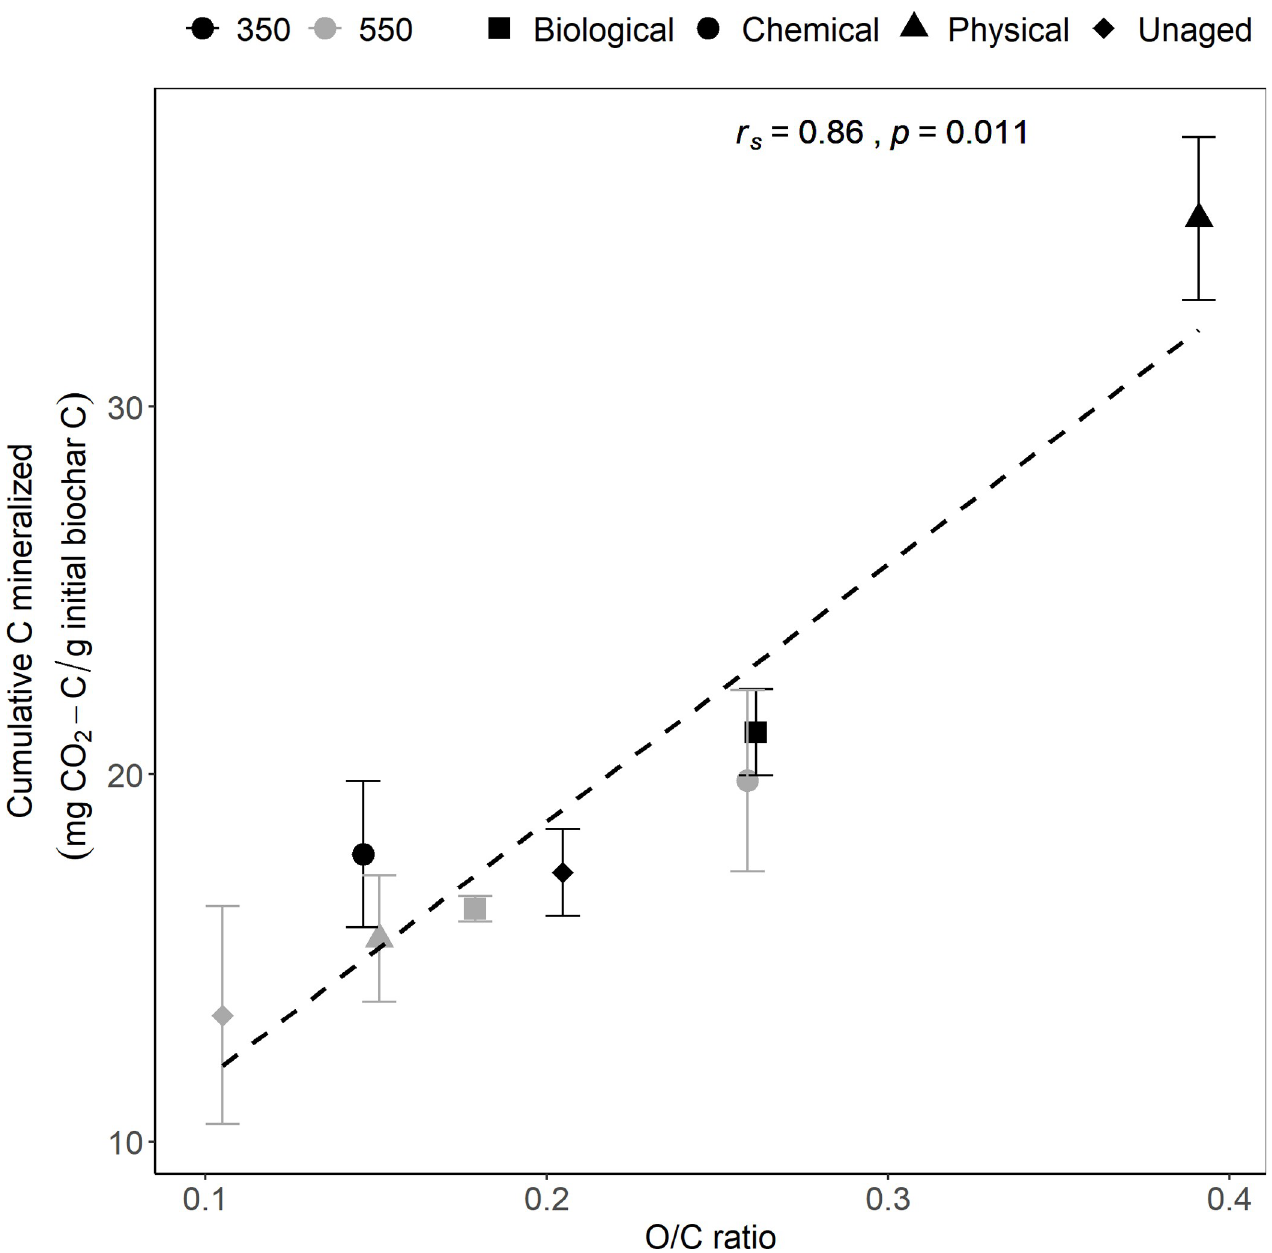
Fig 3. Relationship between mean cumulative biochar-C mineralized and molar O/C ratio. N = 3 for physical, chemical and unaged, N = 5 for biological treatments. Error bars represent standard error of the mean. Shapes indicate unaged, physically, chemically and biologically aged biochar samples produced at 350˚C (black) and 550˚C